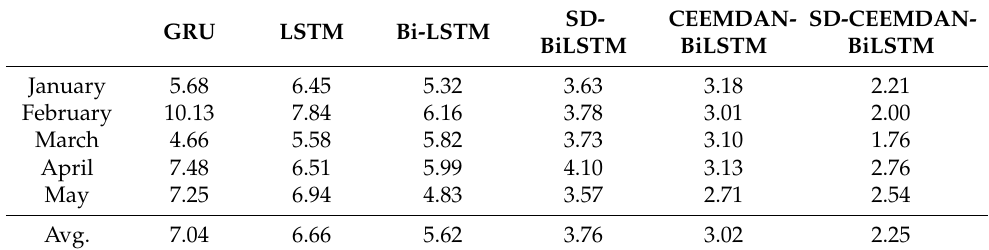
Table 3. MAPE (%) of all the models per month for the one-day-ahead prediction. GRU LSTM Bi-LSTM